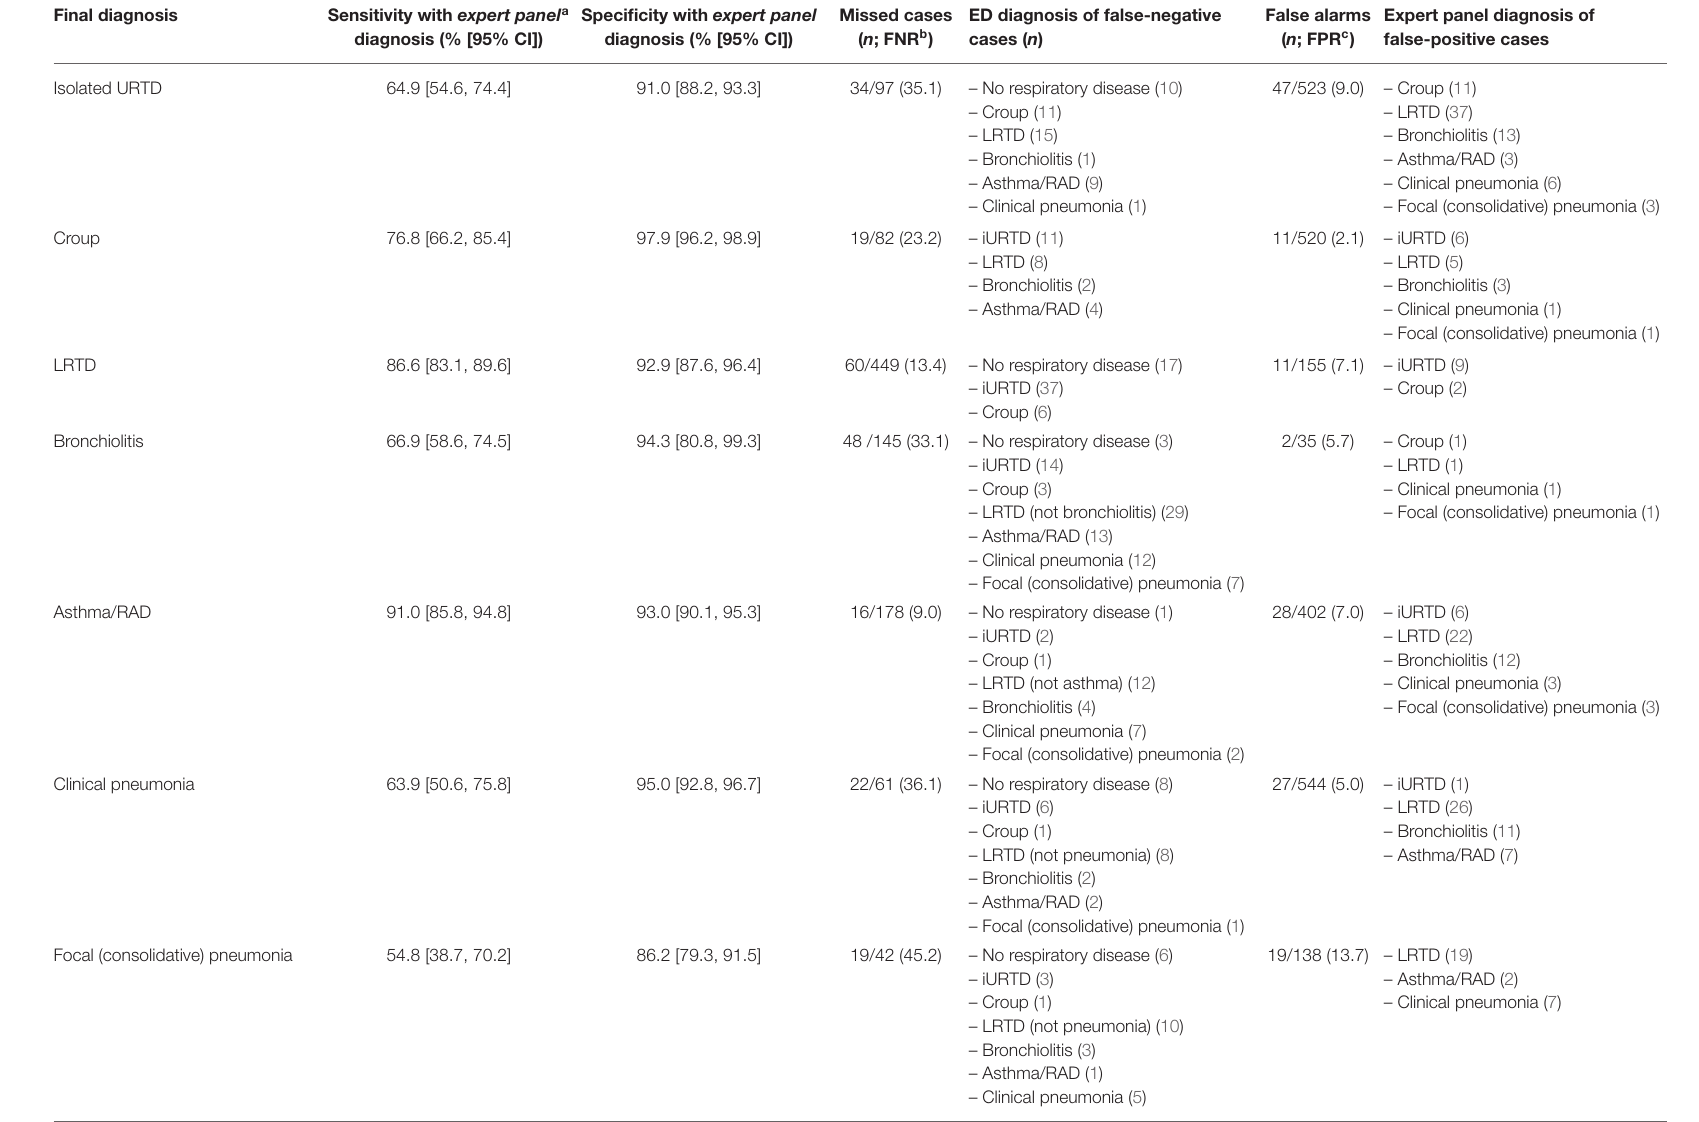
a EP: Expert panel. b FNR: False-negative